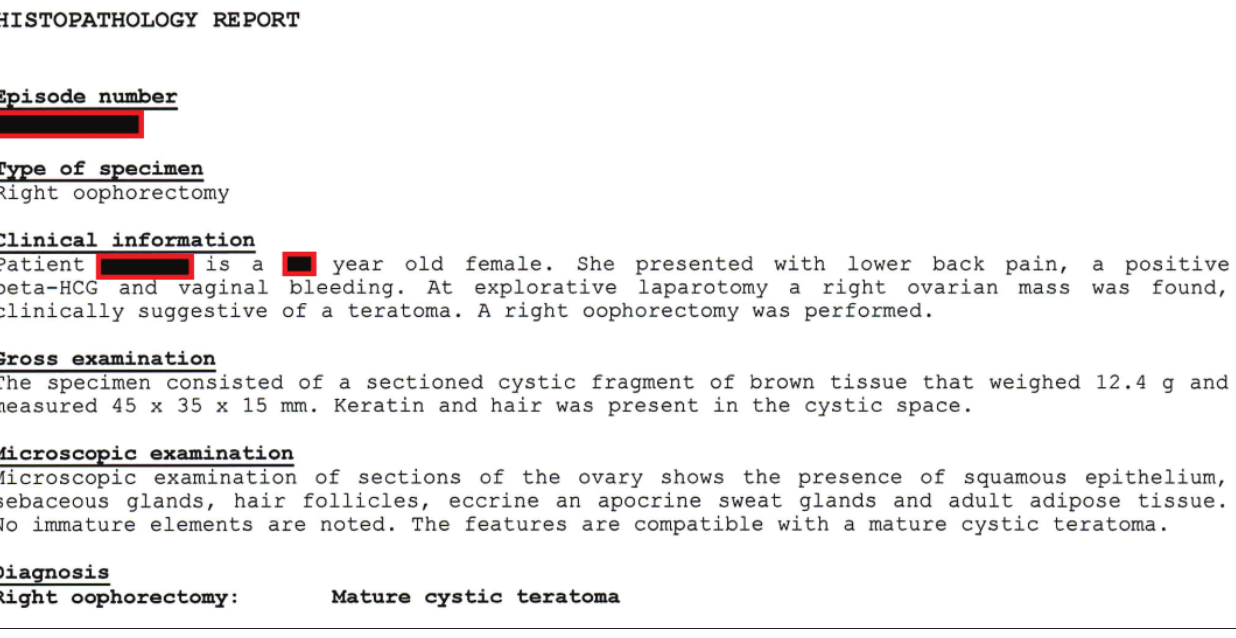
FIGURE 4: Histopathology